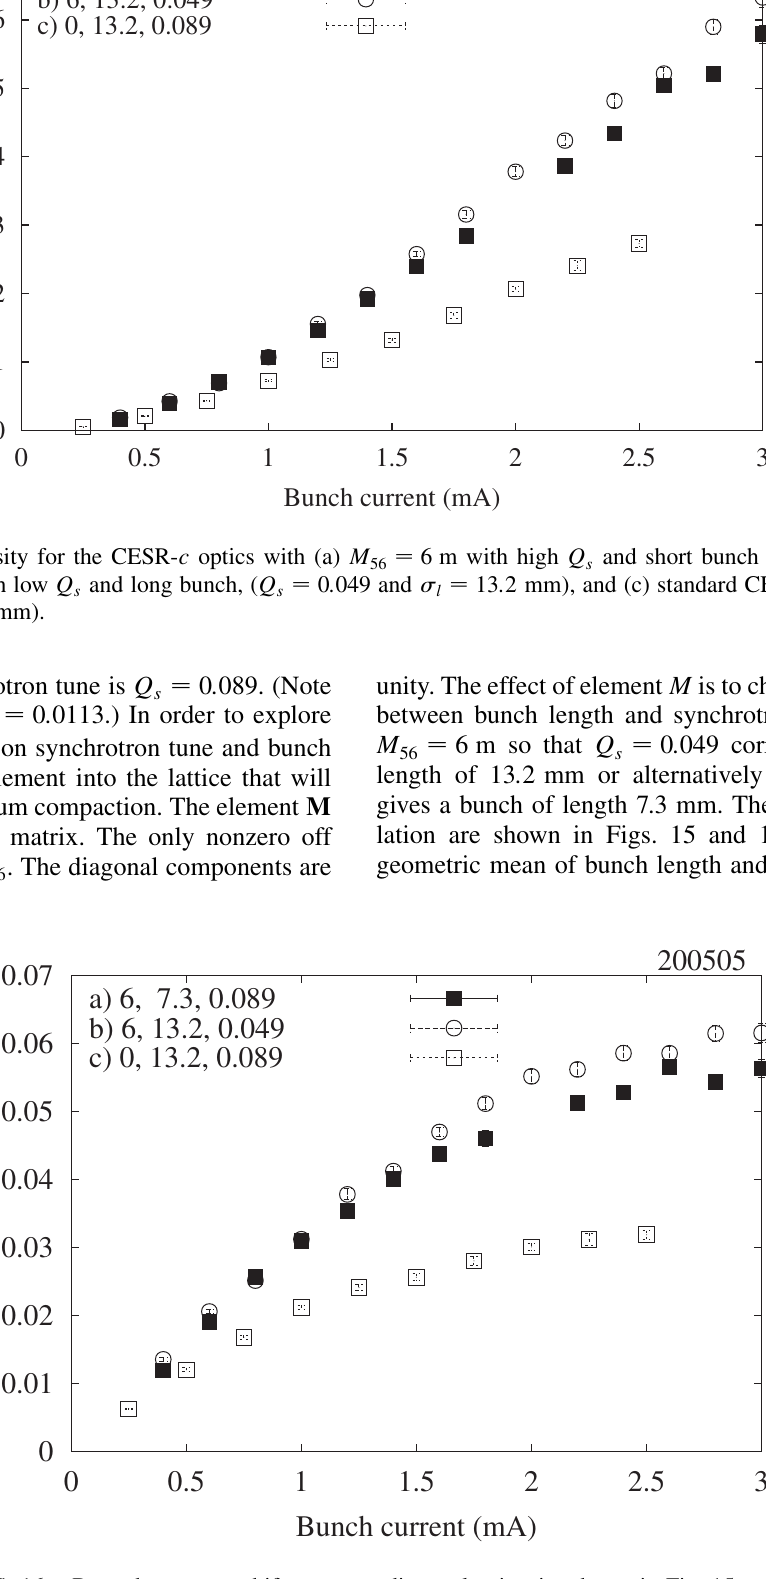
FIG. 16. Beam-beam tune shift corresponding to luminosity shown in Fig.